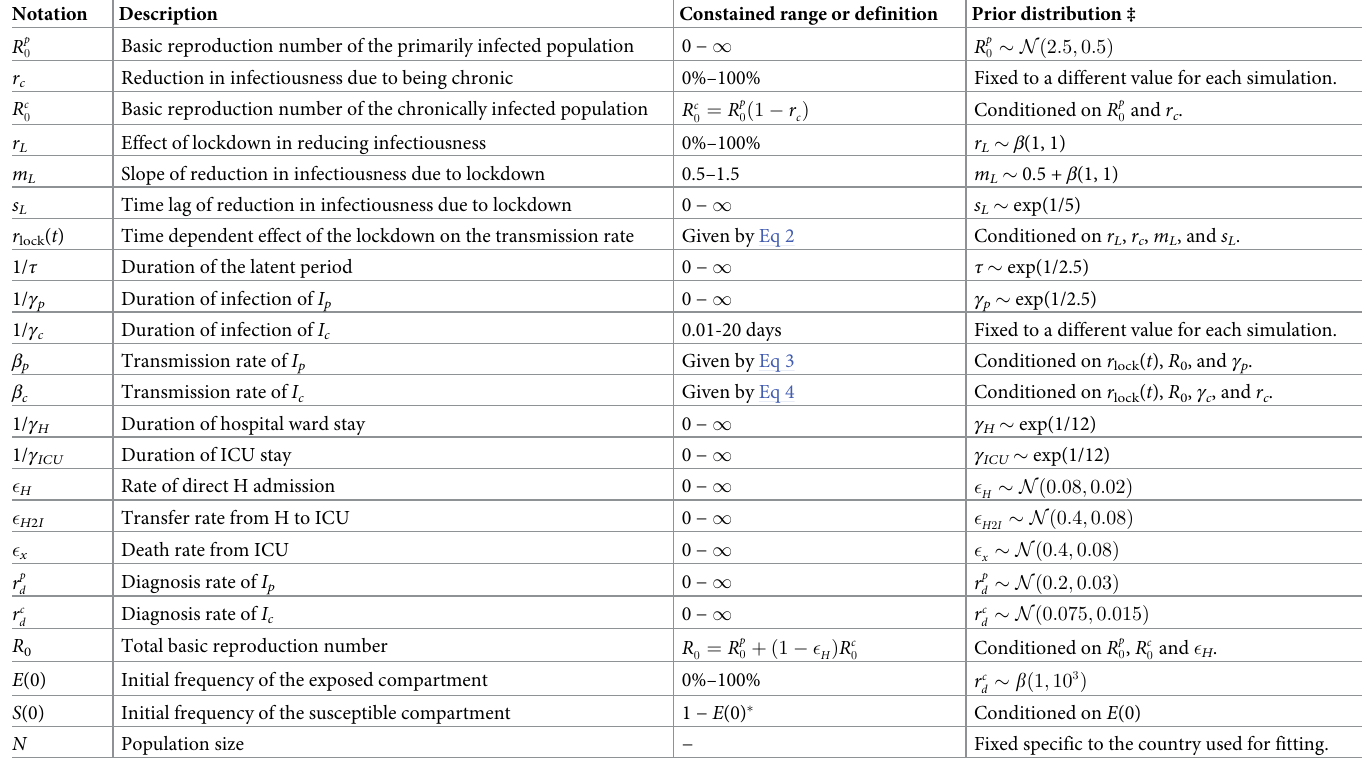
Table 1. Model parameters given with their descriptions, constrained ranges, and prior distributions.